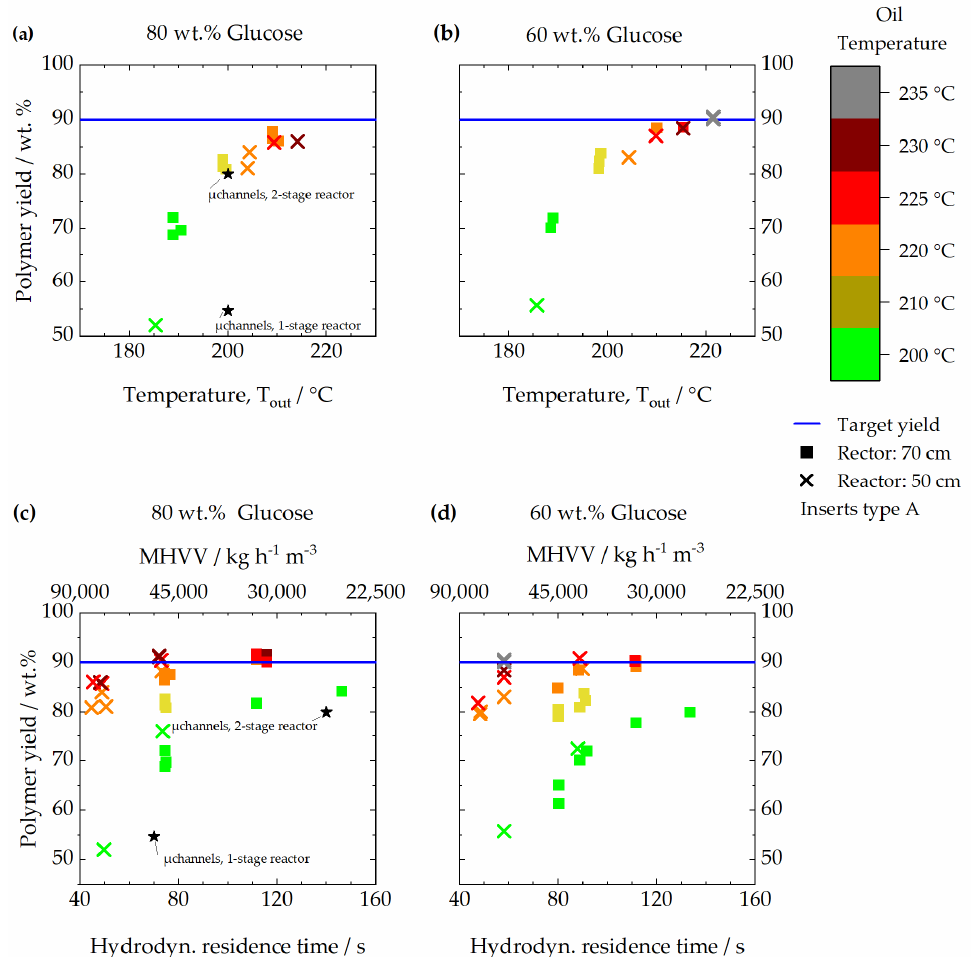
Figure 7. Product yield vs. outlet temperature for ( a ) 80%wt. glucose solution in feed ( b ) 60%wt. glucose solution in feed. Product yield vs. hydrodynamic residence time for ( c ) 80%wt. glucose solution in feed ( d ) 60%wt. glucose solution in feed. The MHVV is also indicated in the graph. The results for a 70 cm reactor are compared with the results with a 50 cm reactor. The pressure was 2 ± 0.5 bar. Literature values according to [1] are given as a comparative value.